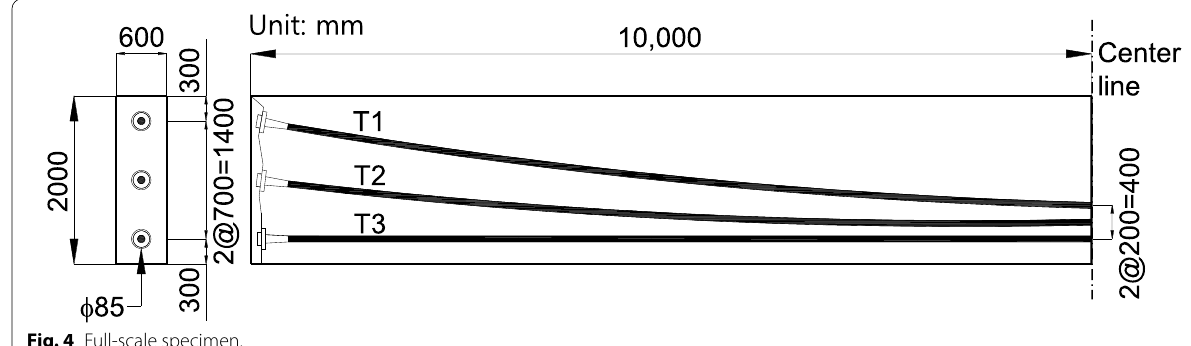
Fig. 4 Full‑scale specimen.